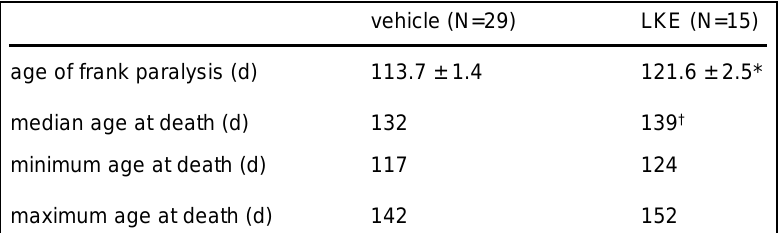
Table 2. Effects of LKE on clinical parameters in SOD1 G93A